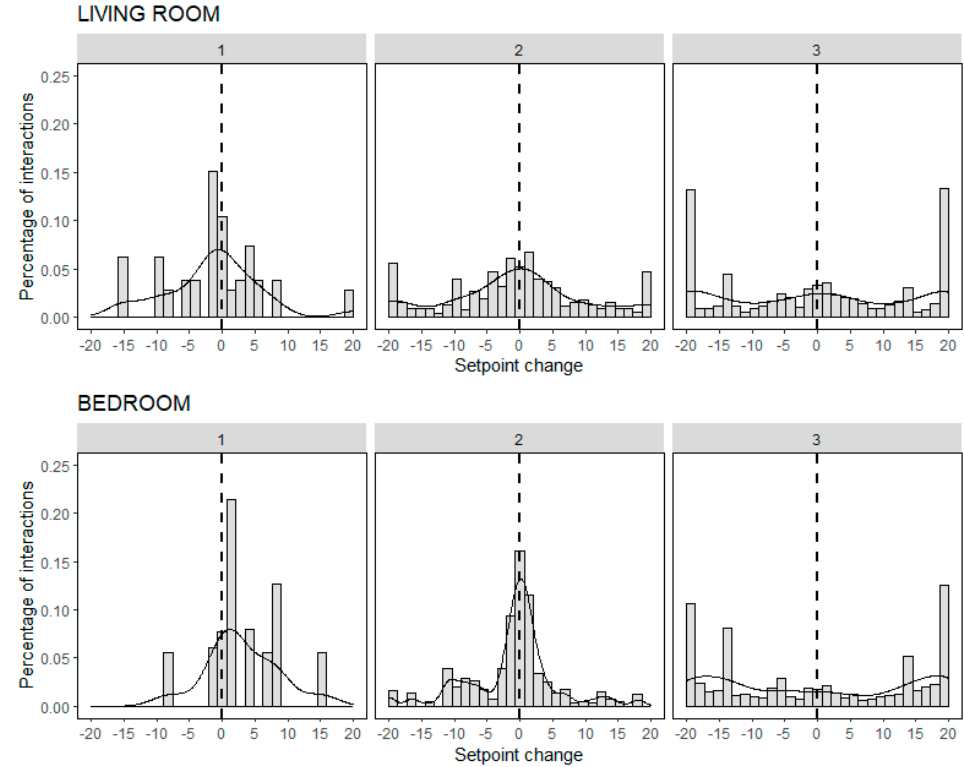
Figure 5. Distribution of STV setpoint changes by room and group. Interactions were weighted by the number of observations in each flat. The dotted line represents a setpoint change of zero, meaning no change. Columns to the left represent interactions where the setpoint was lowered, and columns to the left, interactions where the setpoint was increased. Group 1 shows no discernible patterns, as the number of interactions is very low. Group 2 shows a higher percentage of small setpoint changes (less than 5 degrees). Group 3 shows a two-tailed distribution, where most of the interactions are maximum changes to the limit of the STV (from fully open to fully closed and vice versa).